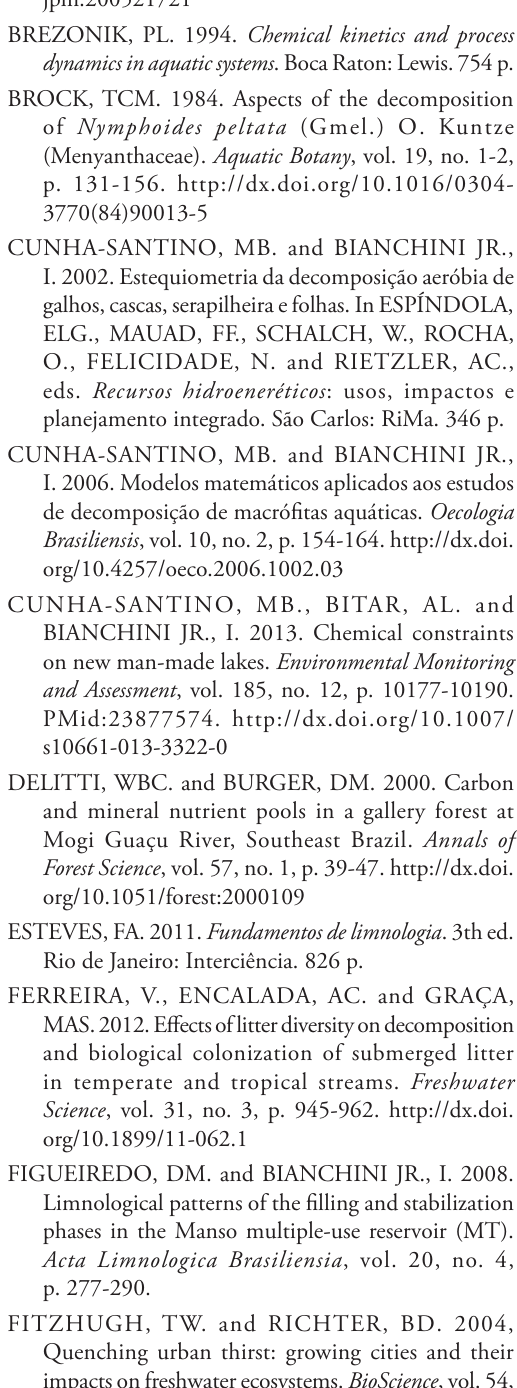
FIGUEIREDO, DM. and BIANCHINI JR., I.